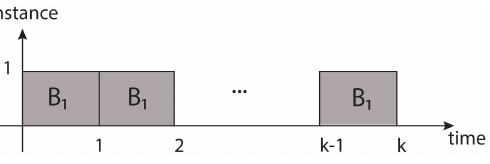
Figure 9. One block ( B 1 ) is processed in sequential form during k latency’s time.